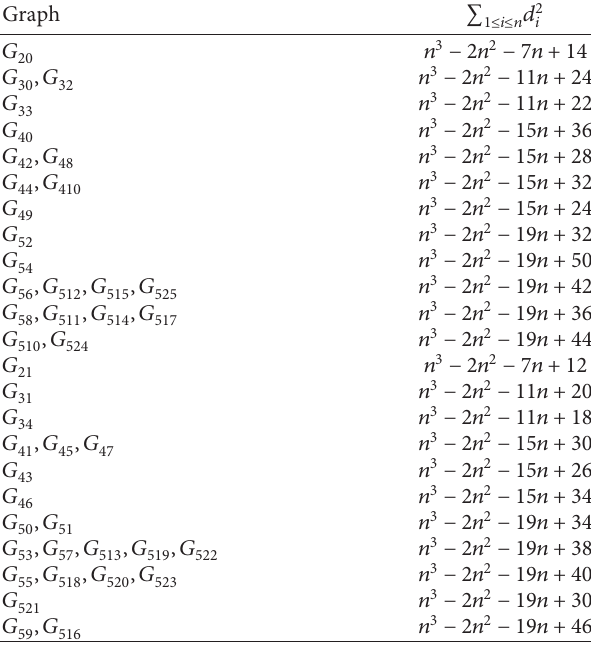
Table 4: The sum of squares of degrees of some graphs in G